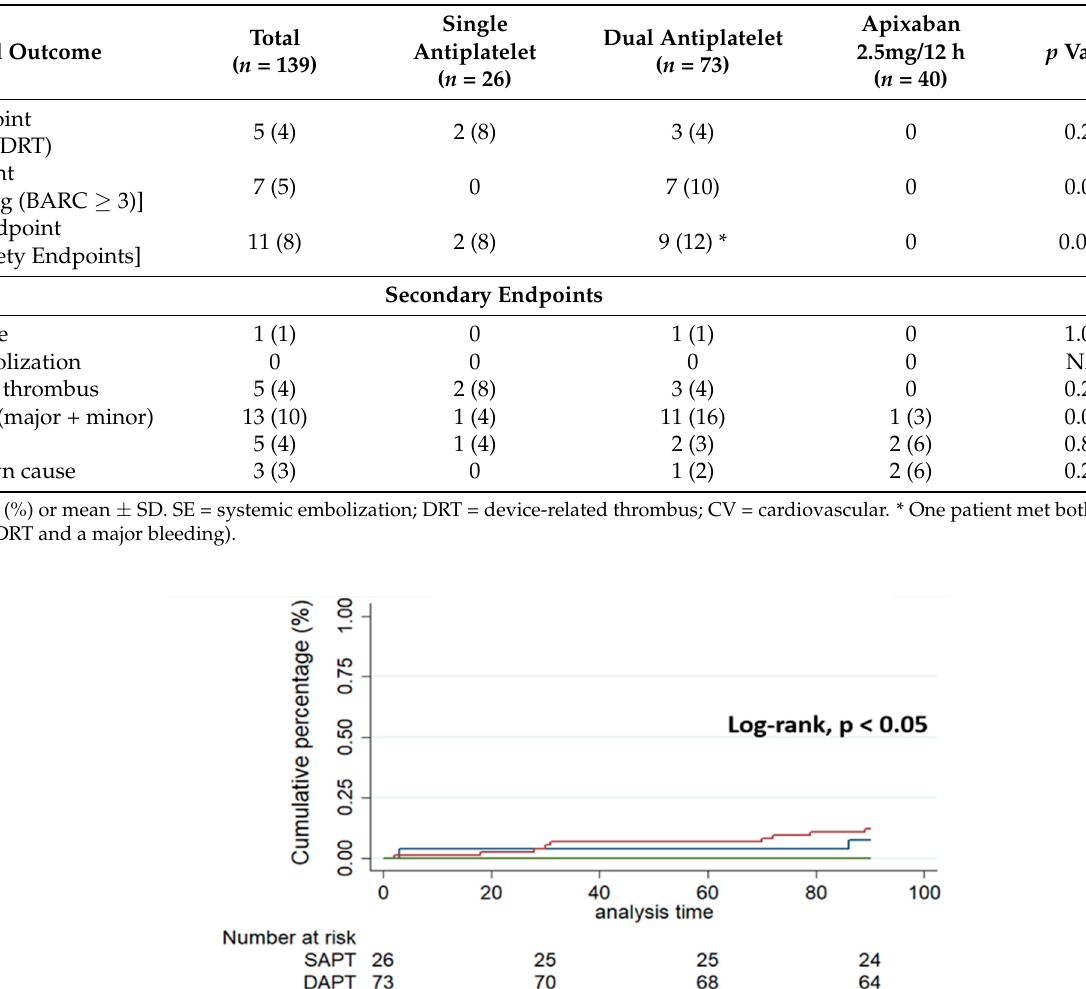
Table 3. Clinical outcomes 3-months follow-up.